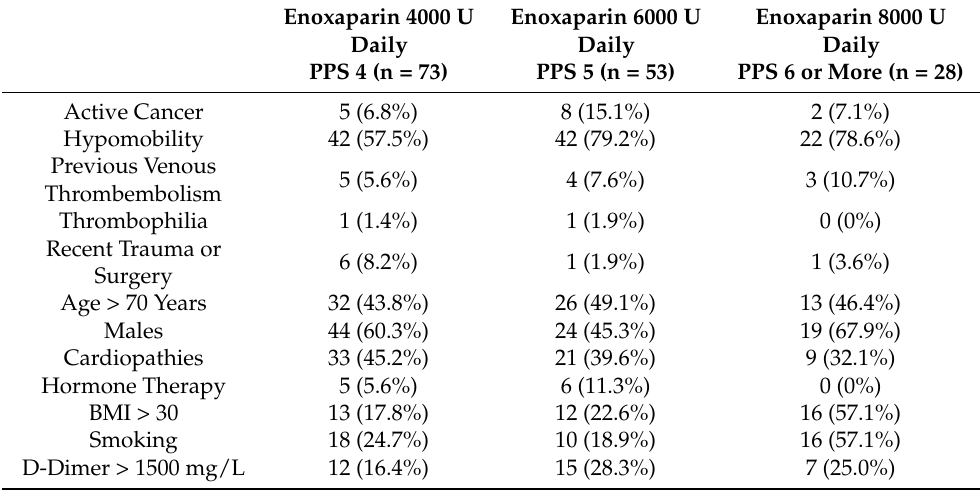
Table 1. Main baseline and clinical characteristics of the study patients in each of the three study